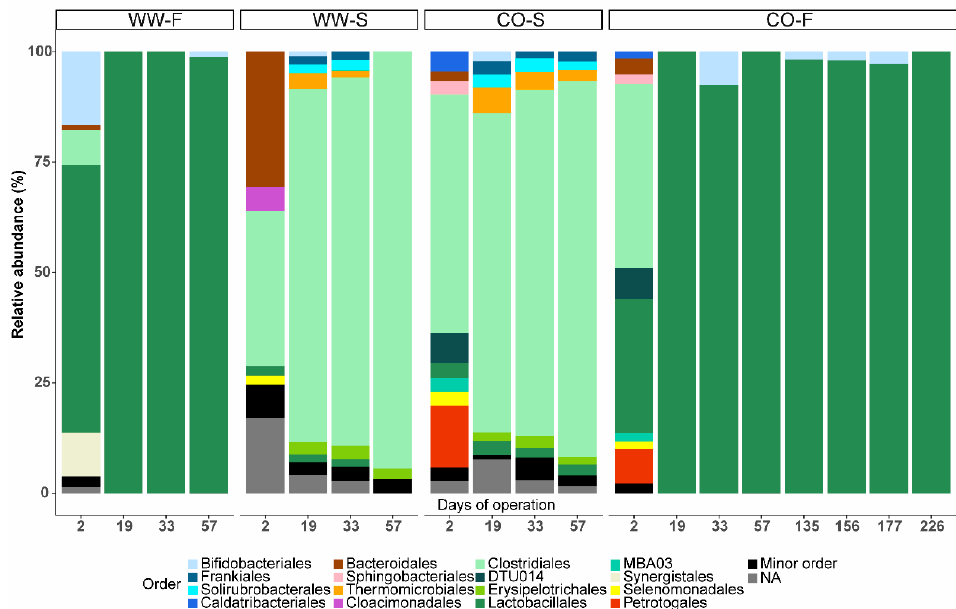
Figure 7. Relative abundance of microbial order (based on total bacterial and archaeal sequences) in reactors inoculated with sludge from the co-digestion plant (CO) or an anaerobic digestion process fed mixed sludge (WW) and fed food waste (F) or sewage sludge (S). Days of operation at the point of sampling are given on the x -axis.